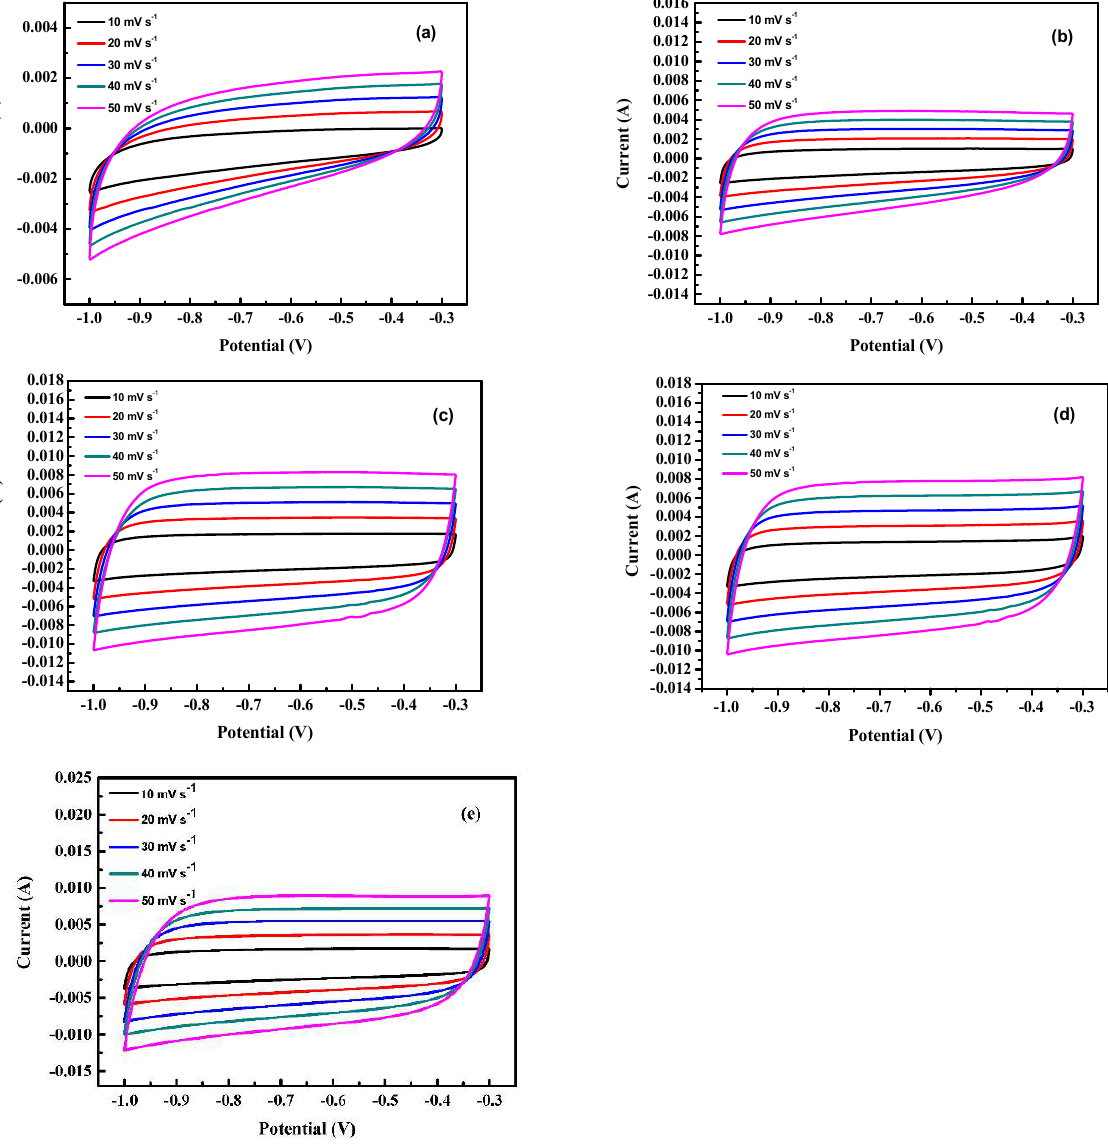
Figure 7. The CV characteristics of the as-prepared activated carbon electrodes. ( a ) Run 21, ( b ) run 20, ( c ) run 15, ( d ) run 2, ( e ) optimal.